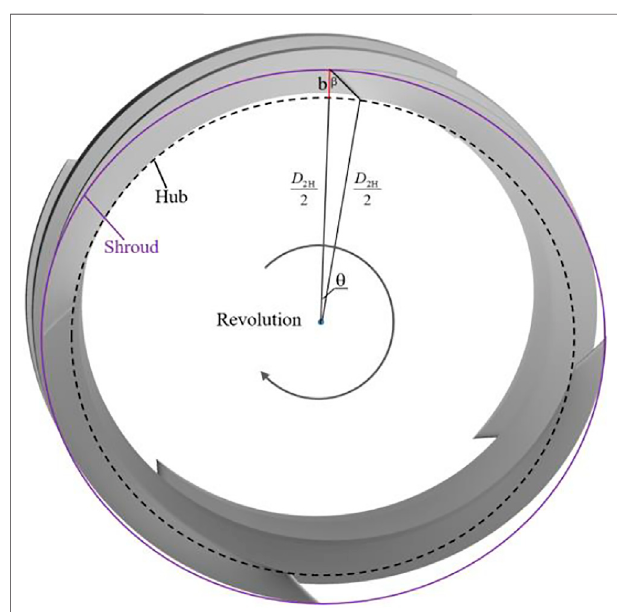
FIGURE 9 | De fi nition of high-pressure edge angle.